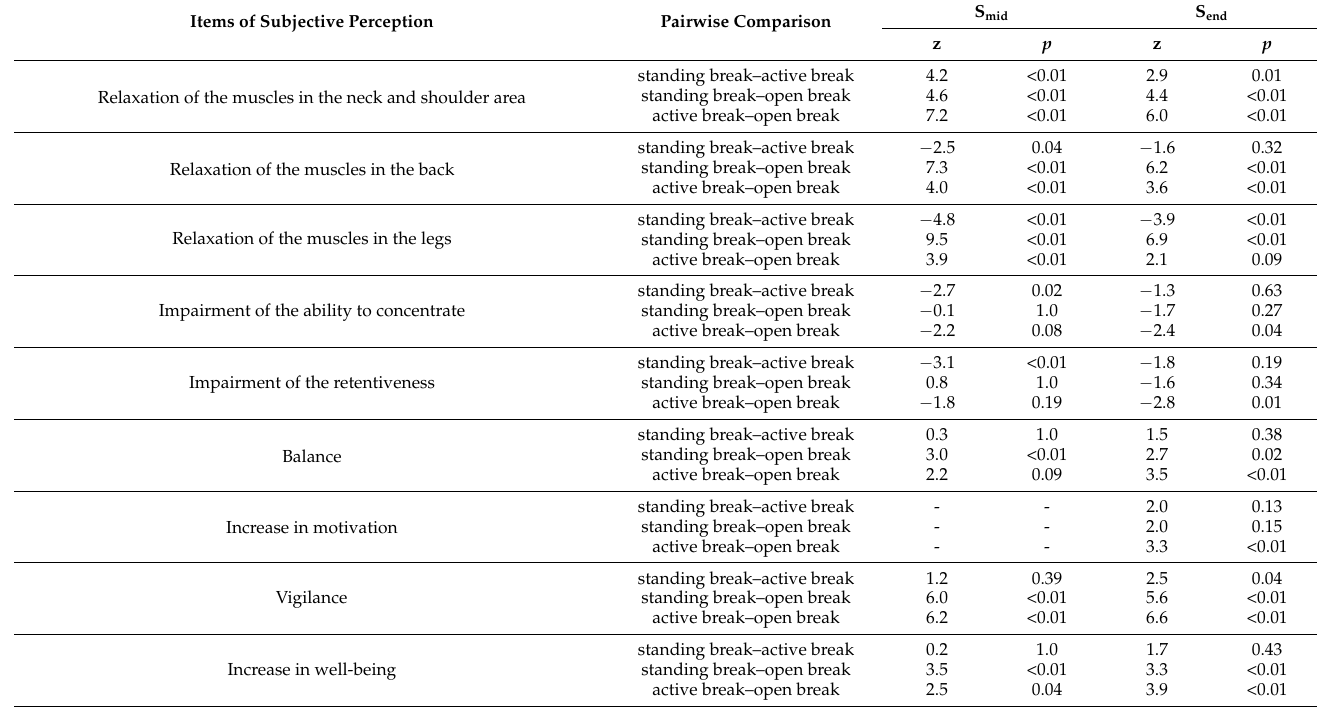
Table 7. Results of the Dunn–Bonferroni test at S mid (N = 631) and S end (N =